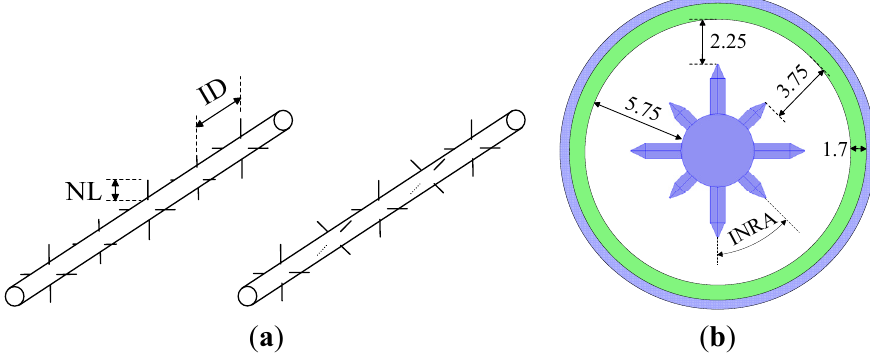
Figure 1. The MC configurations used in the current work: ( a ) The configurations of INRA = 0° (left) and INRA = 45°; ( b ) Cross section of the electrode with NL = 3.5 + 2 mm and INRA = 45° (units in millimeters).